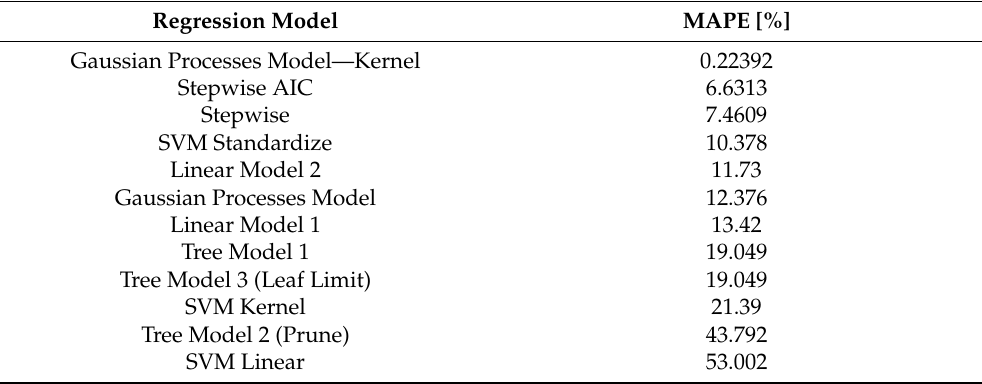
Table 3. Computational results for mdl in the operation system of the test object with a single BESS.